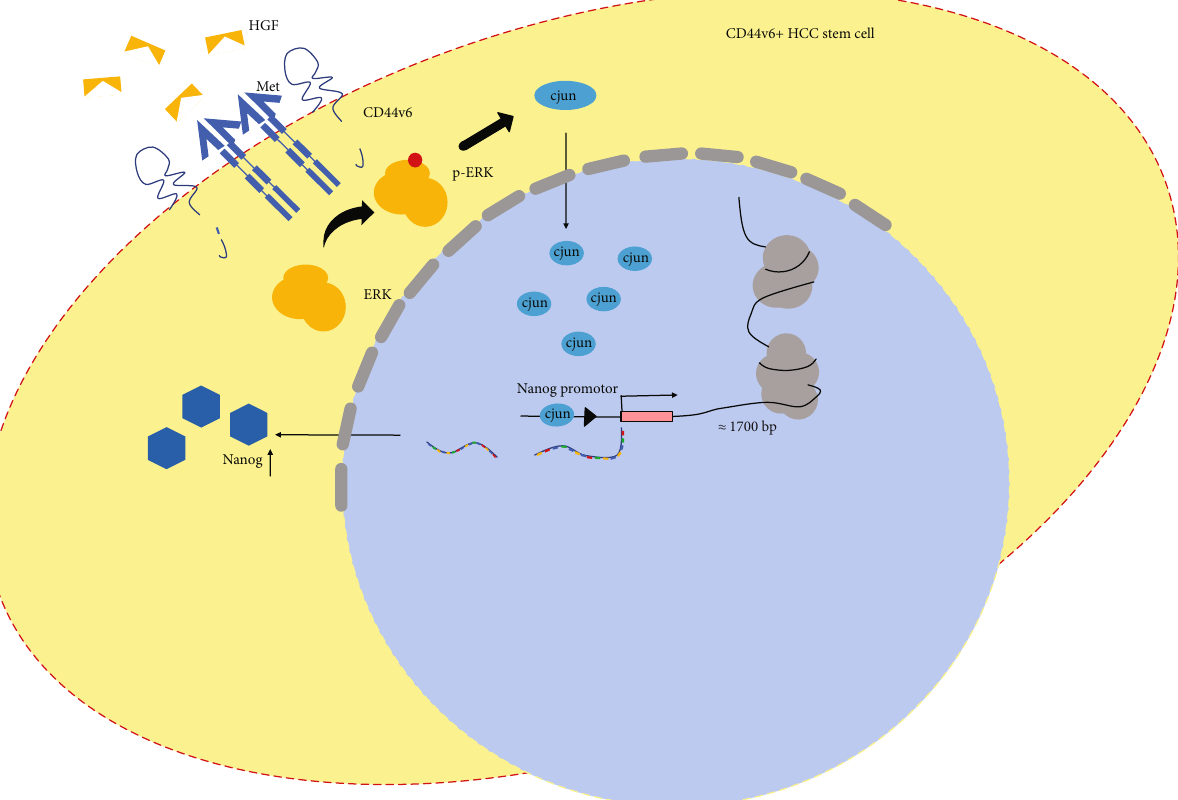
Figure 5: Schematic illustration of the mechanism by which the transcription factor cJun is binding in the transcription start site of Nanog and then promotes the Nanog expression, contributing to the maintenance of stemness of CD44v6+ HCC